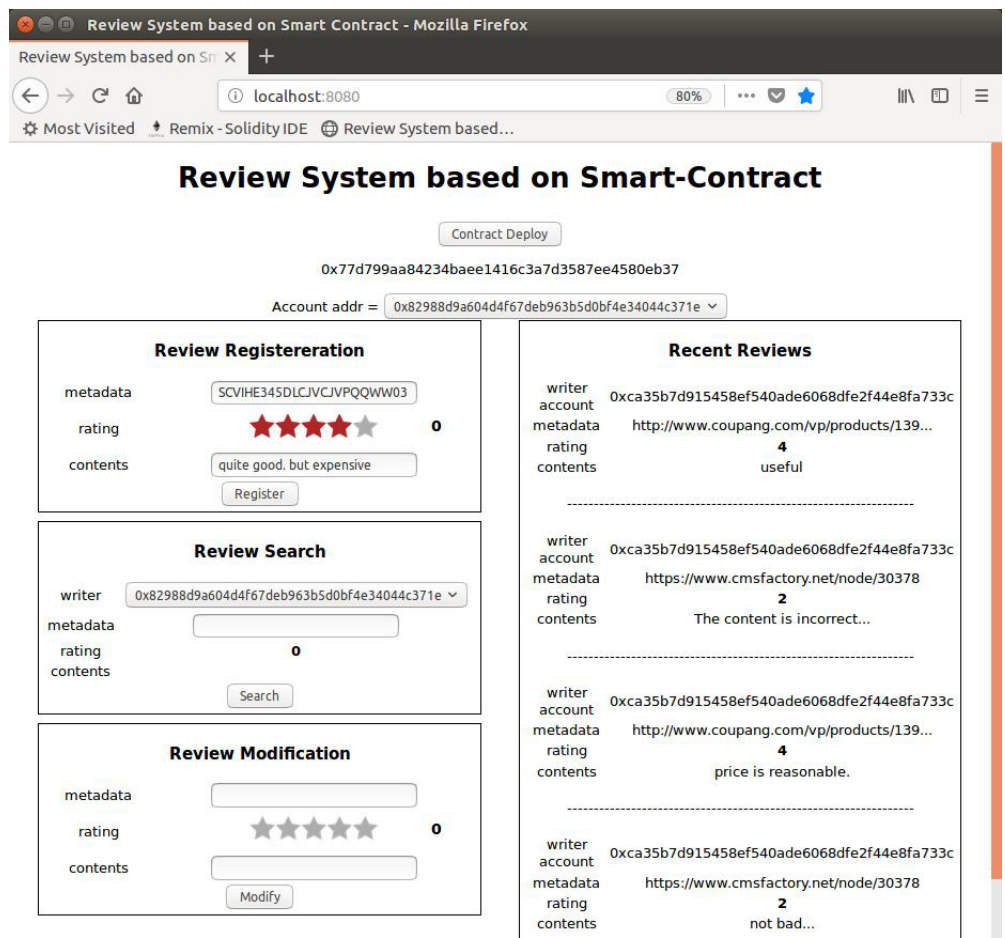
Figure 7. Developed HTML